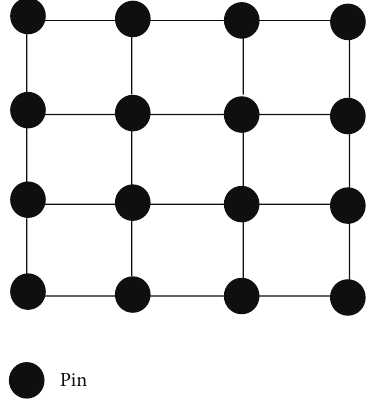
Figure 2: Routing region of size 4 × 4